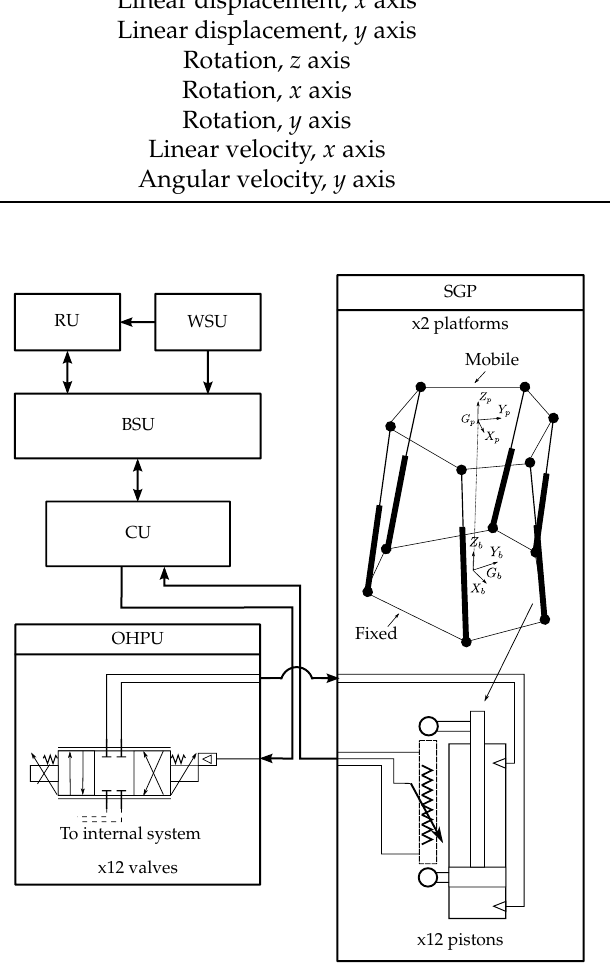
Figure 2. Schematic diagram illustrating the gait simulator composing units, including a representa- tion of main coordinate systems G b (fixed base) and G p (mobile